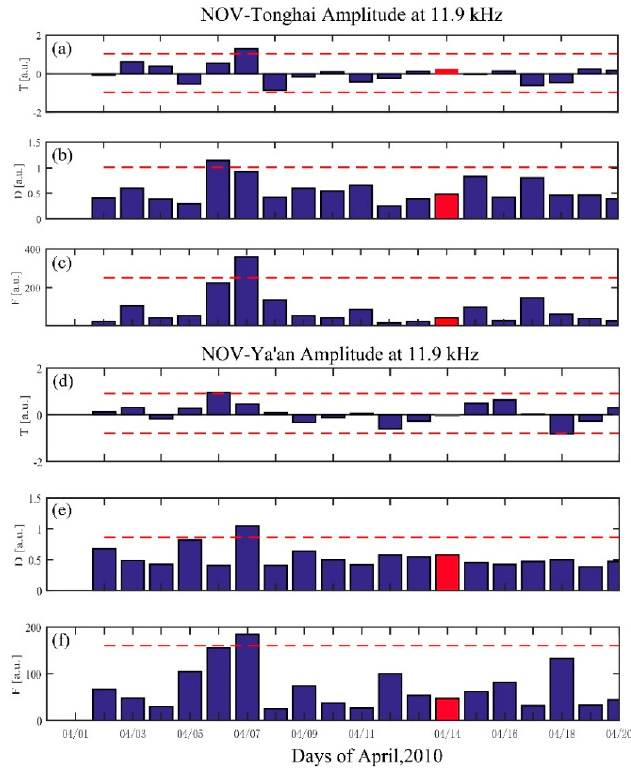
Figure 3. Nighttime fluctuation analysis around the Yushu earthquake on 14 April 2010 in red. The trend (T) ( a , d ), dispersion (D) ( b , e ), and fluctuation (F) ( c , f ) between NOV-Tonghai and Ya’an at F1 are shown separately. The horizontal line in each panel depicts the 2 σ deviation criterion to define the anomalous